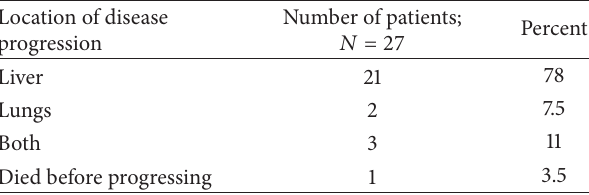
Table 4: Sites of disease progression after